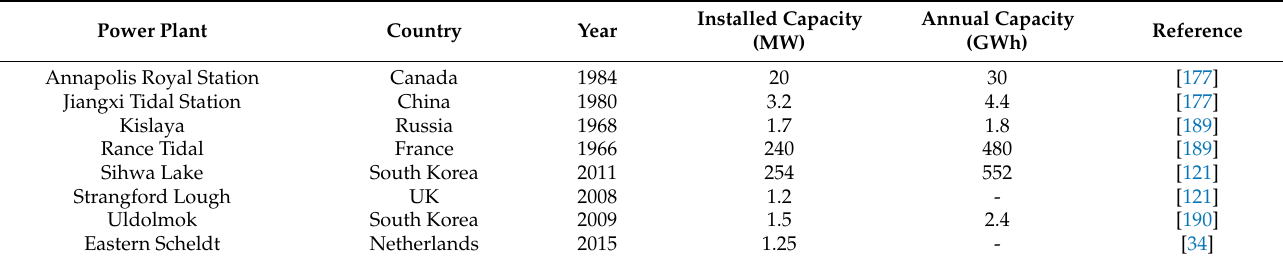
Table 7. Operational tidal power plant.